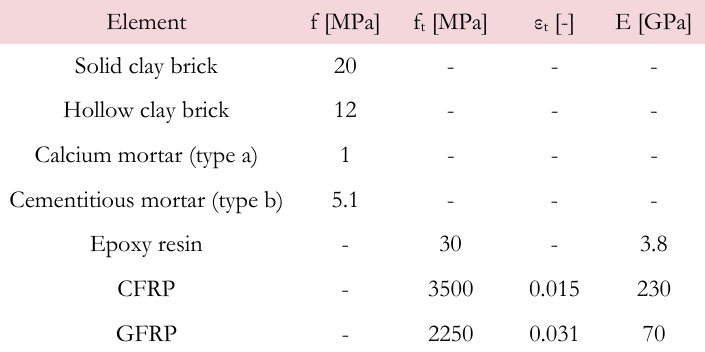
Table 4.A: Mechanical properties of constituents for the experimental tests